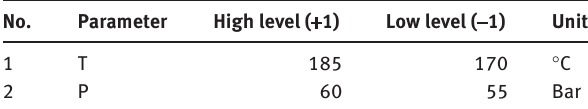
Table 2: High-level and low-level parameters.